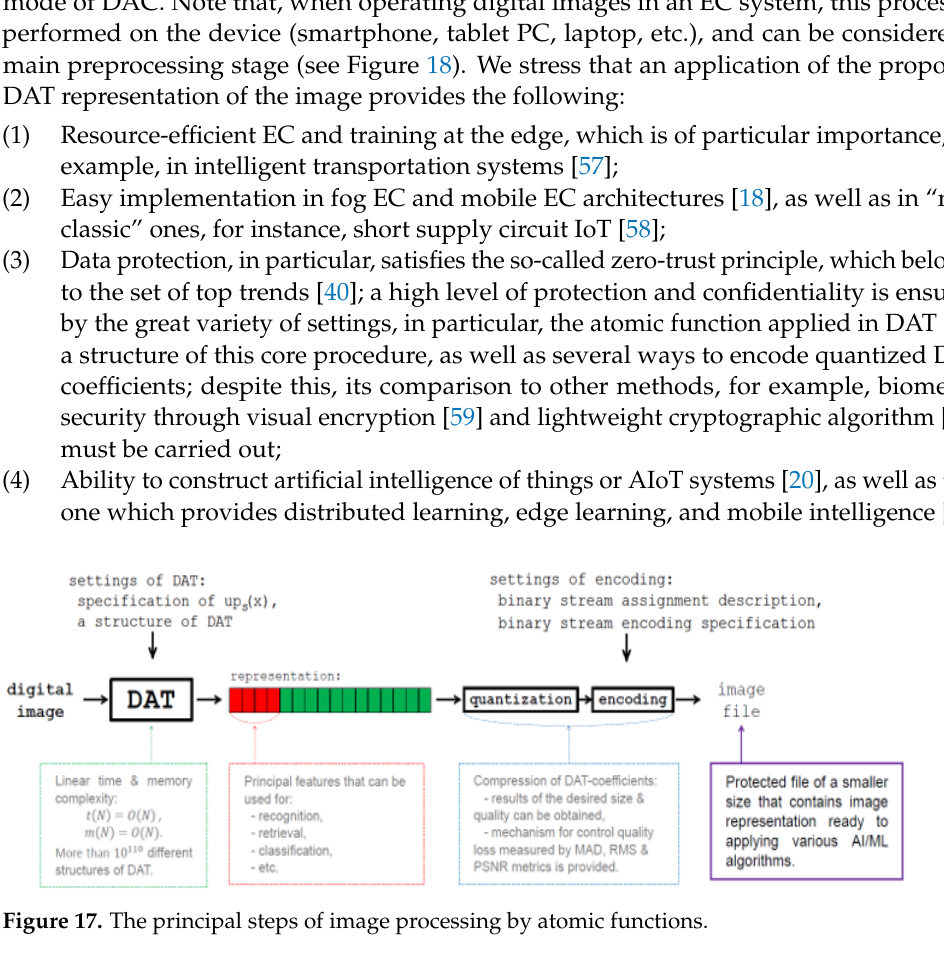
Figure 18. Application of atomic functions in image processing for EC in IoT systems. Finally, from Table 9 and Figure 15, it follows that lossless DAC provides better com- pression than ZIP. This illustrates the fact that, in general, the algorithms which are de- veloped to compress data of some special type, have higher performance than methods which can be applied to compressing data of any type [26]. Additionally, storing the test